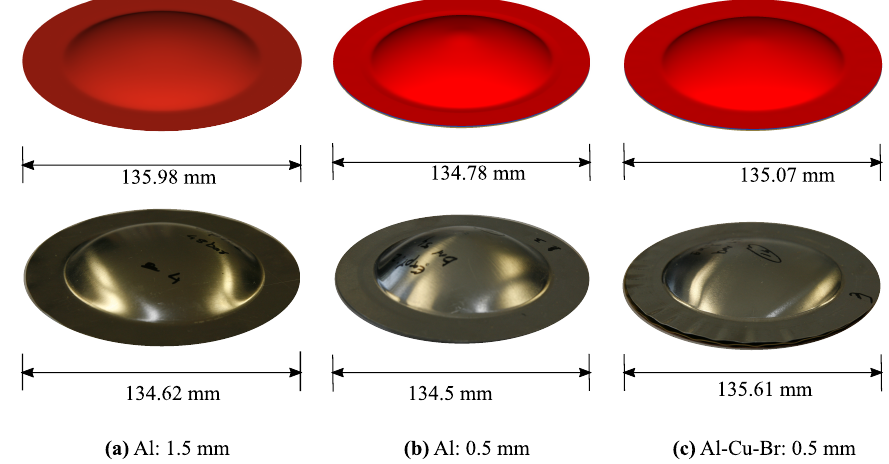
Figure 9. Diameter comparison of the deformed sheets between the experiments and numerical simulations for ( a ) 1.5 mm single plate of Al, ( b ) 0.5 mm stacked plates of Al and ( c ) 0.5 mm stacked plates of Al-Cu-Br.